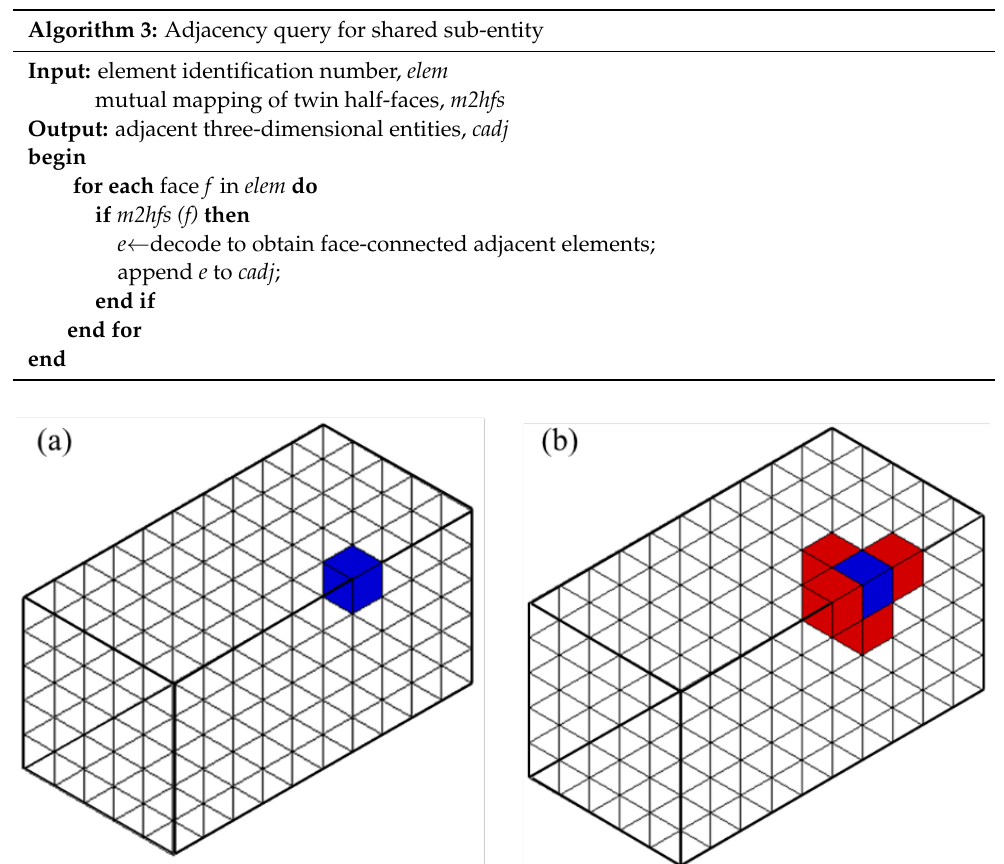
Figure 6. An example of a 3-D element adjacency query. For ( a ) a given blue element, it shows ( b ) adjacent red elements.